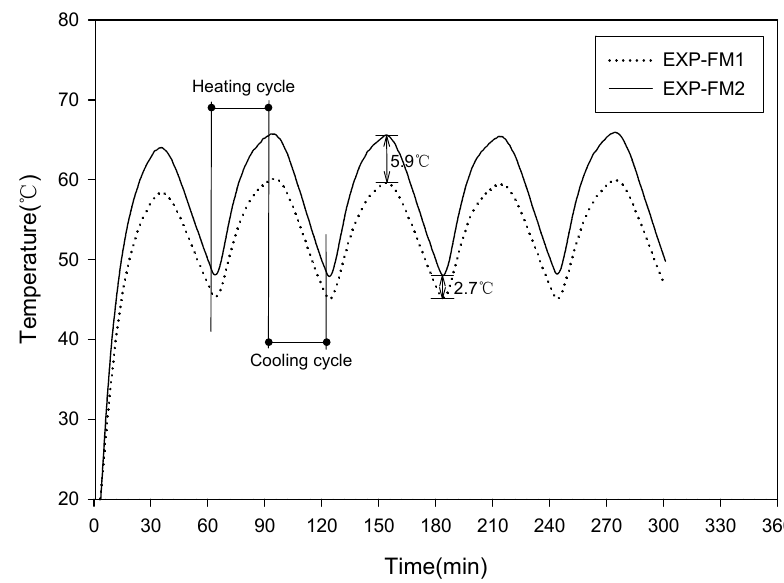
Figure 12. Characteristics of heat diffusion and storage (repeated heating).